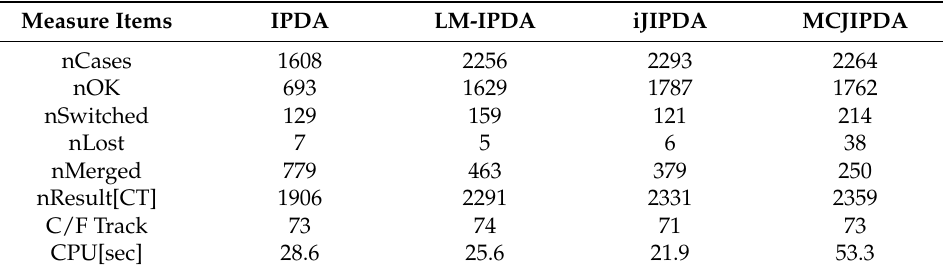
Table 5. Track retention statistics for Case #2.